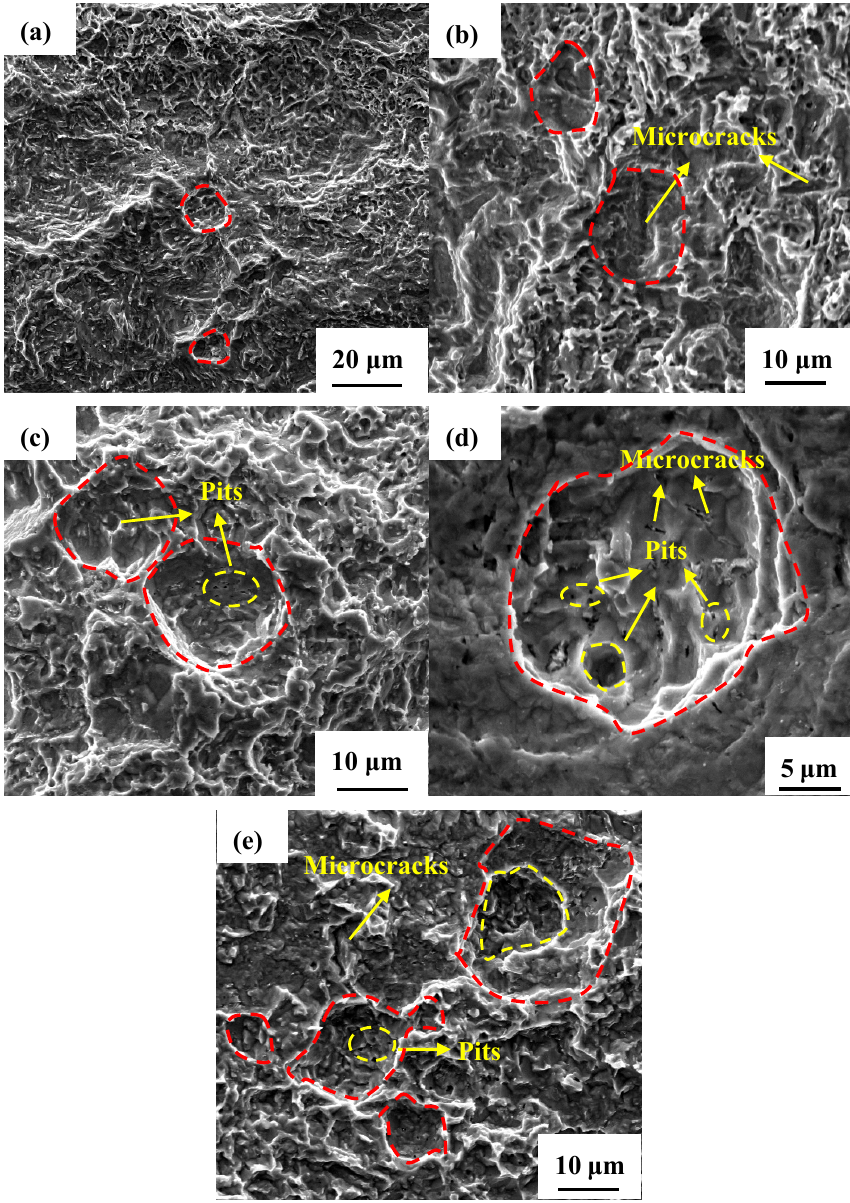
Figure 7. Surface morphologies of the U-bend samples immersed for 30 days in different AC densities: ( a ) 0 A/m 2 ; ( b ) 10 A/m 2 ; ( c ) 30 A/m 2 ; ( d ) 50 A/m 2 ; and ( e ) 100 A/m 2 .